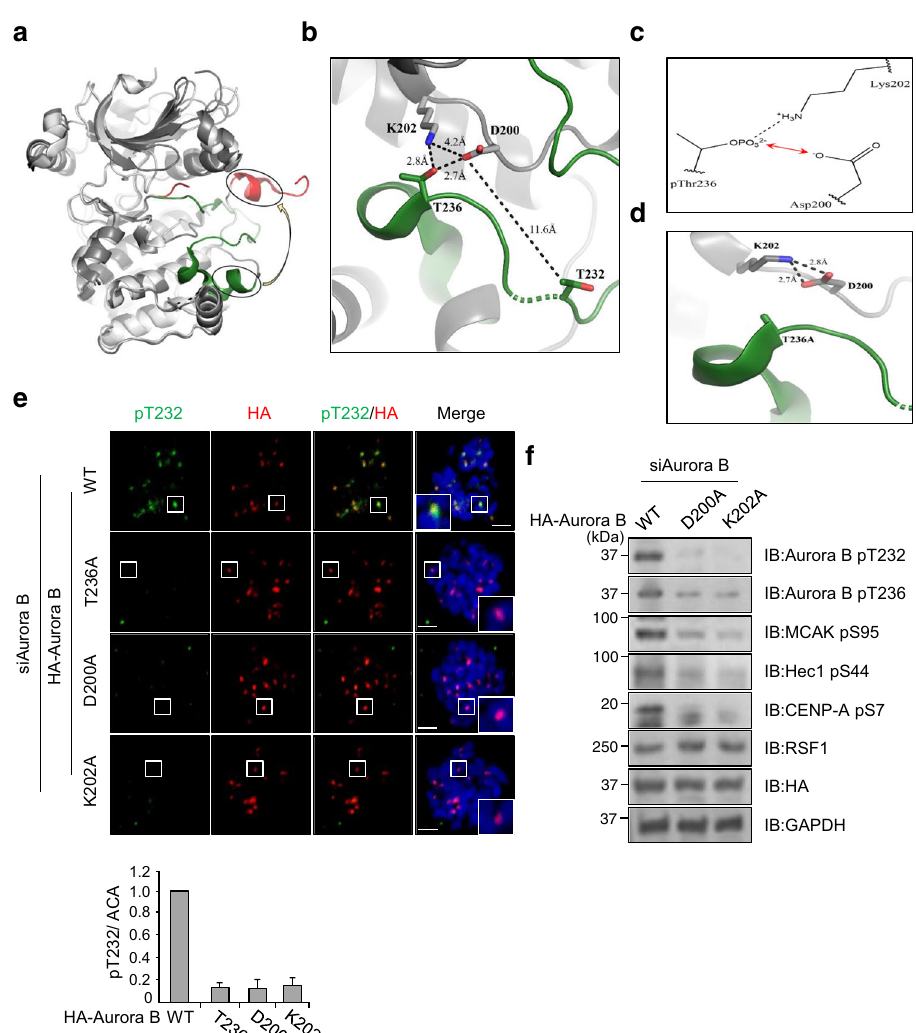
Fig. 5 Structural basis of Aurora B autophosphorylation mechanism via the phosphorylation of T236. a The superposed crystal structures of human and Xenopus Aurora B proteins that are colored in white and gray, respectively. The activation loops in human and Xenopus Aurora B are in red and green, respectively. A yellow arrow indicates the positional difference between identical helices highlighted by circles. b Structural arrangement of Asp200, Lys202, Thr232, and Thr236 in the crystal structure of the Xenopus Aurora B-INCENP complex (PDB code: 2BFX). The activation loop is colored in green. Black dashed lines between residues in sticks represent distances. Nitrogen and oxygen atoms in sticks are colored in blue and red, respectively. c The putative interaction mode among Asp200, Lys202, and pThr236. A red arrow represents the electrostatic repulsion, whereas a black dashed line does an electrostatic interaction. d The putative interaction mode among Asp200, Lys202, and Ala236 when Thr236 is mutated to alanine. Black dashed lines between residues in sticks represent distances. e Floating mitotic cells were obtained after nocodazole treatment for 4 h and subjected to immuno fl uorescence image: pT232-Aurora B (green), HA (red), and DAPI (blue). Bars represent mean ± SEM from three independent experiments; WT n = 22, T236A n = 28, D200A n = 38, nK202A = 34 cells. Scale bar, 5 μ m. f HA-Aurora B WT or D200A/K202A mutants were transfected in Aurora B-depleted cells and analyzed by immunoblotting. Data of f are representative of two independent experiments. Source data are provided as a Source Data fi